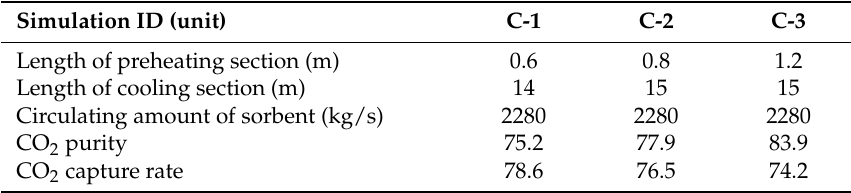
Table 6. Effect of length of preheating section on process performances for Conf-C.